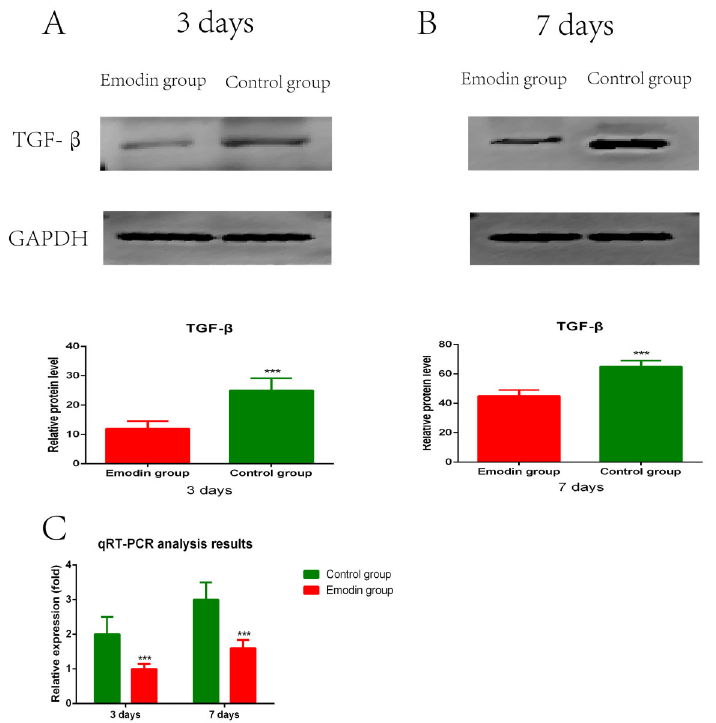
Figure 4 . Emodin suppressed transforming growth factor (TGF)- b expression in implanted polyvinyl alcohol (PVA) sponges at 3 and 7 days post-injection. A – C , PVA sponges were removed at 3 and 7 days after implantation. Macrophages were isolated from PVA sponge exudates and assessed for TGF- b expression at the protein ( A and B ) and mRNA ( C ) levels by western blot and qPCR, respectively. GAPDH was used as a reference in these assays. Representative images of western blot bands are shown, and relative expression of TGF- b is summarized ( A and B ). Data are reported as means ± SE for n=3 for each group. ***P o 0.001 vs the Control group (two-tailed t